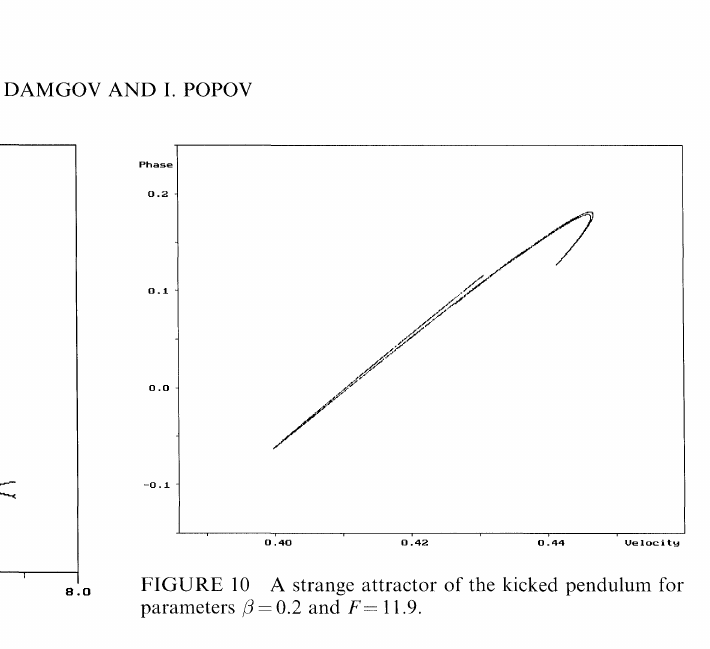
FIGURE 8 Bifurcation diagram for the whole family of FPs (black) and period-3 points surrounding each of them (grey).